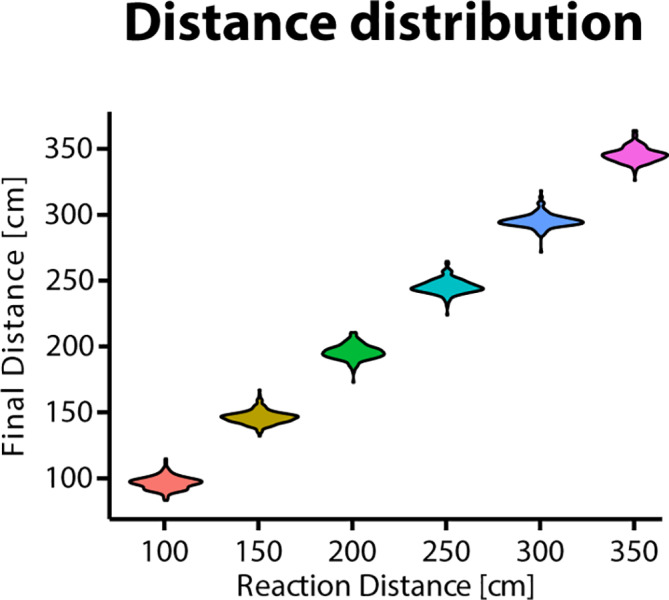
Violin plot depicting the distribution of final distances which were set by the participants after the virtual agents changed from a passive to an active mode.